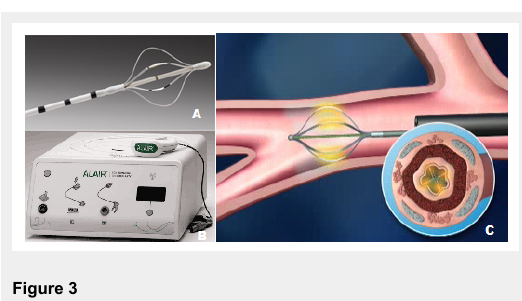
A- Alair Catheter; B- Alair RF Controller; C- Schematic representations of using the